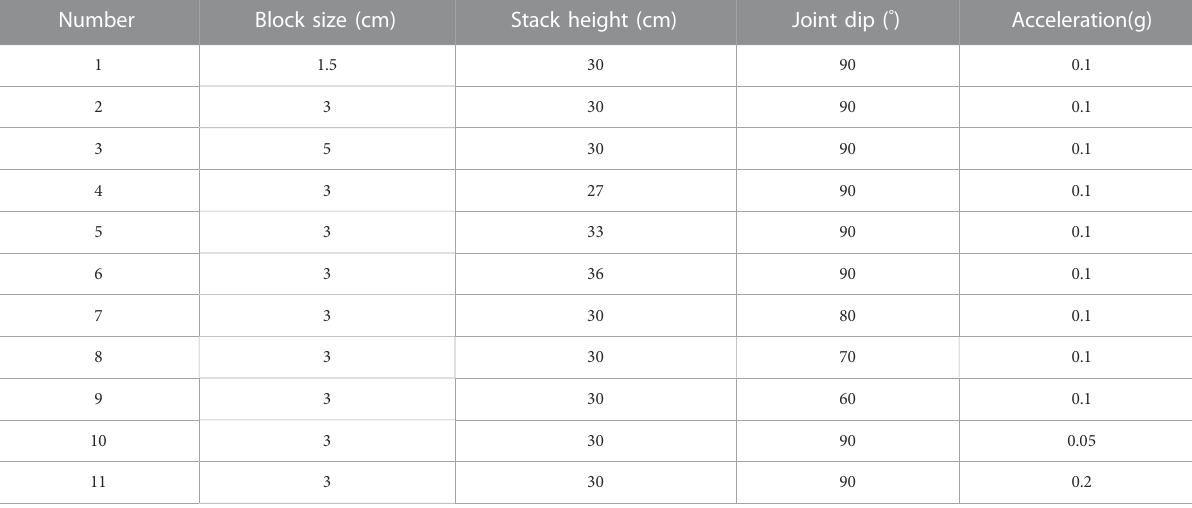
TABLE 2 Experimental conditions and scheme of the model experiments. Number Block size (cm) Stack height